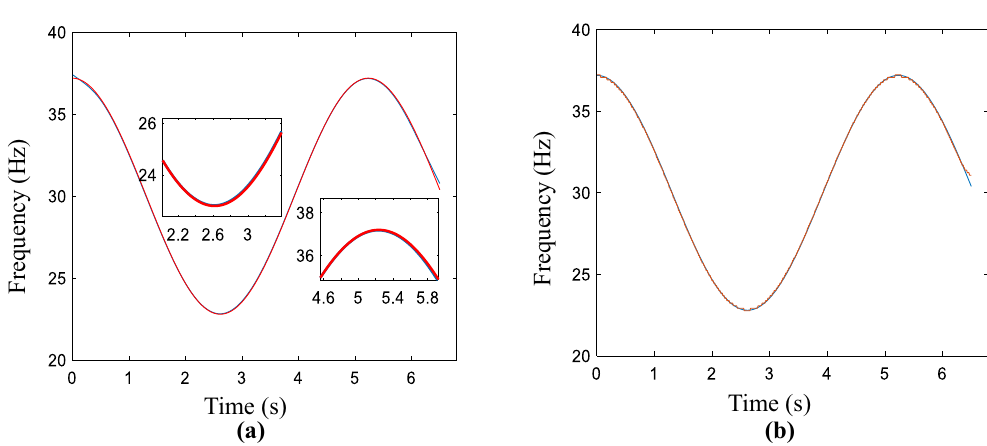
Figure 2. Simulated signal. ( a ) Obtained result by using the proposed method, ( b ) the estimated and real